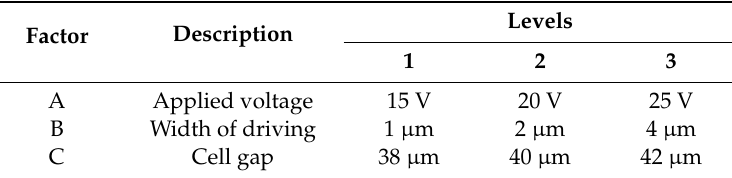
Table 1. Levels of each control factor.